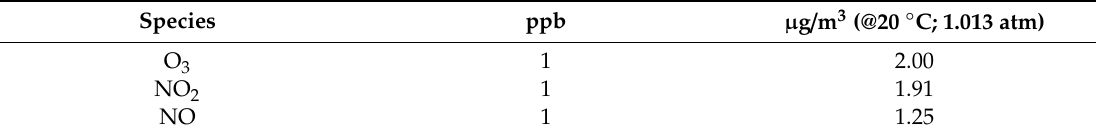
Table 1. Conversion ppm to µ g / m